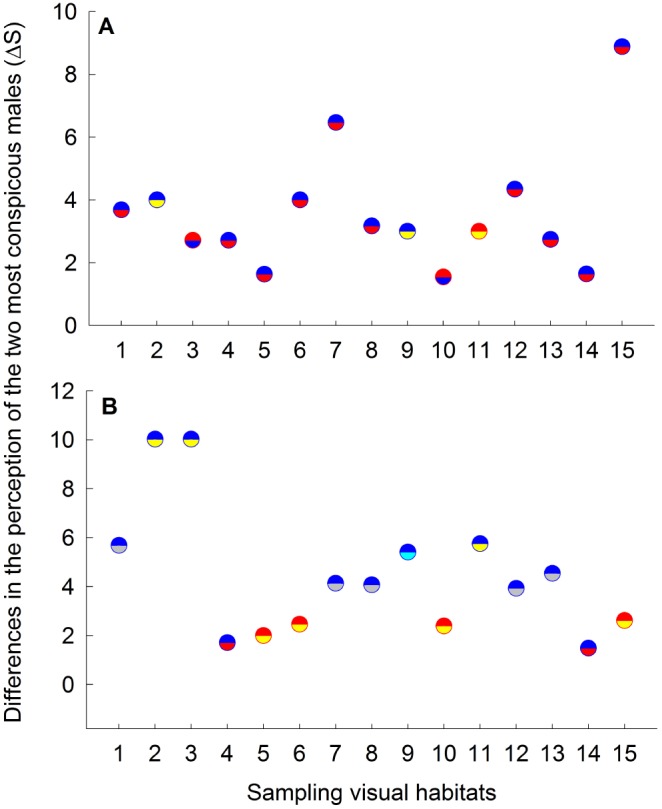
Differences in the perceived chromatic contrast between the two most conspicuous males as perceived by a common predator across different sampling sites in the (A) east and (B) west populations.Differences were calculated by subtracting the ΔS values of the most conspicuous color morphs from the ΔS values of the second most conspicuous morph at each sampling site. Upper half of each circle represents the most conspicuous male color morph, while the lower half represents the second most conspicuous color morph at each site. Blue, red, yellow, immaculata and parae male color morphs are represented by blue, red, yellow, gray and magenta colors, respectively.